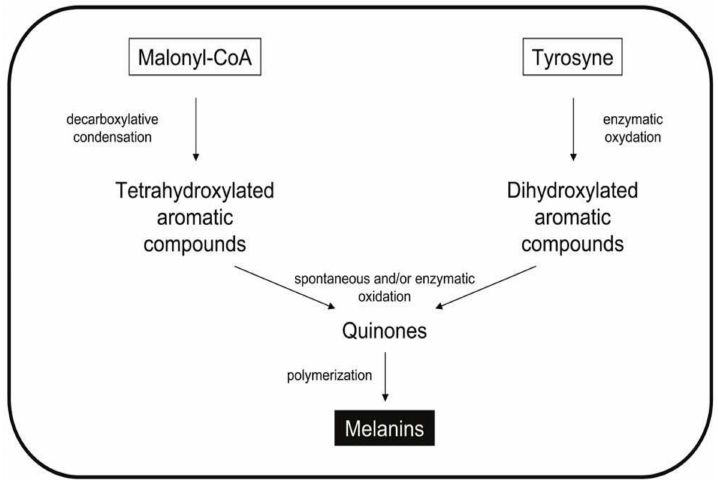
Figure 3. Metabolic pathways for the synthesis of